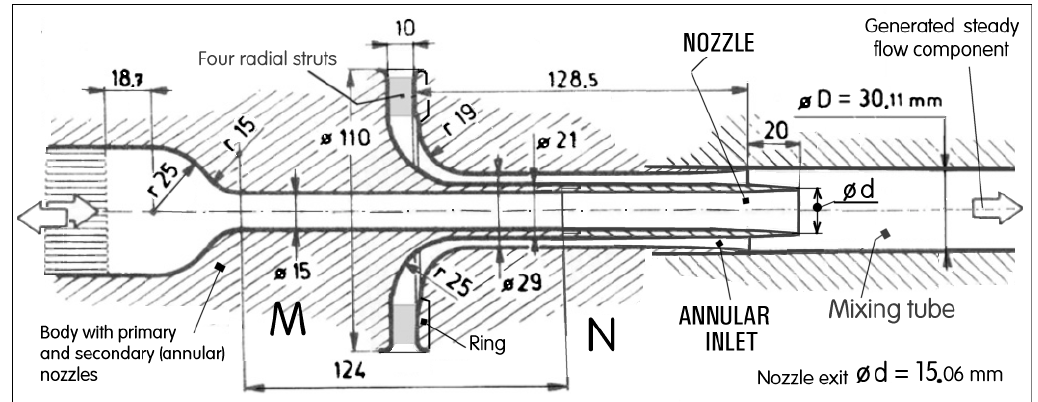
Figure 4. Geometry of the investigated fluidic rectifier. The alternating flow was supplied to the left into the central primary nozzle. The secondary annular nozzle was supplied with the air sucked in through the radial inlet (10 mm-wide) from the atmosphere. In the experiments presented in Figures 8 and 9, the flow rate through the output terminal was zero, as in Figure 2B.